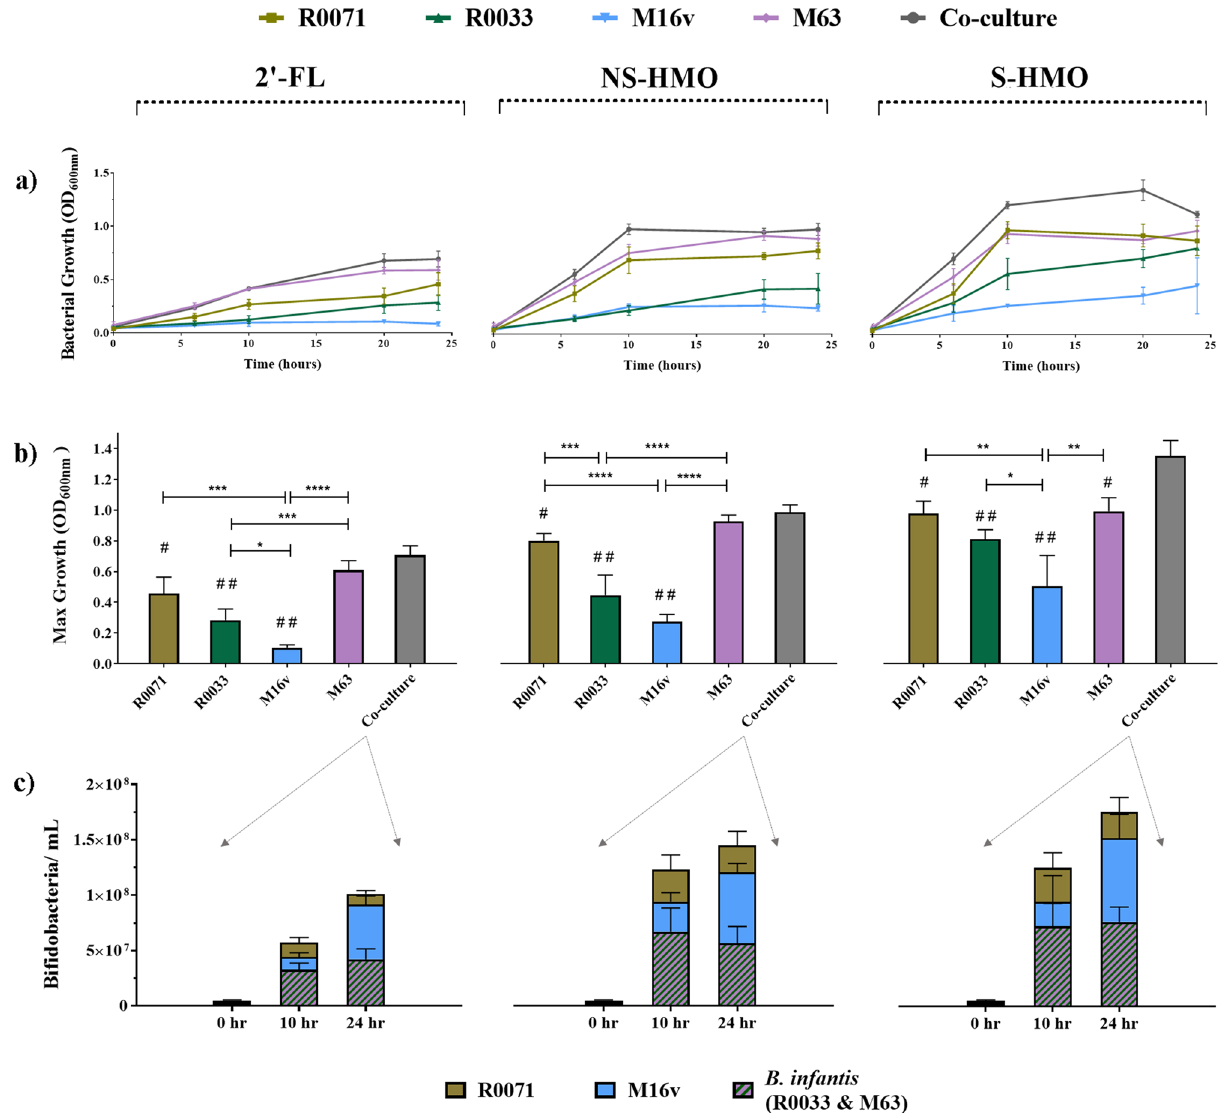
Figure 1. Growth profiles of bifidobacterial strains as mono-cultures and as a four strain co-culture with the following HMO as the sole carbon source: 2’-FL [1.2 g/L], model of NS-HMO [3.8 g/L] and model of S-HMO [5 g/L]. ( a ) Growth of strains in mono- and co-culture at 0 h, 6 h, 10 h, 20 h and 24 h. ( b ) Maximum levels of growth reached by the strains in mono- and co-culture ( c ) Growth (bifidobacteria/mL) of subspecies within the four strain co-culture at 0 h, 10 h and 24 h. Strains within co-culture were quantified using qPCR with primers targeting the 16 s gene region of each subspecies. OD600nm = Optical density at 600 nm. R0071 = Bifidobacterium bifidum R0071, R0033 = Bifidobacterium infantis R0033, M-16V = Bifidobacterium breve M-16V, M-63 = Bifidobacterium infantis M-63. Analysis was calculated using technical triplicate data from biological triplicate experiments and data are means + /−SD. Univariate analysis of variance (ANOVA) and post-hoc Tukey tests were performed to determine the significant differences between the groups (# = p < 0.05, ## = p < 0.001 vs. co-culture) (* = p < 0.05, ** = p < 0.01, *** = p < 0.001, **** = p < 0.0001 between other strain